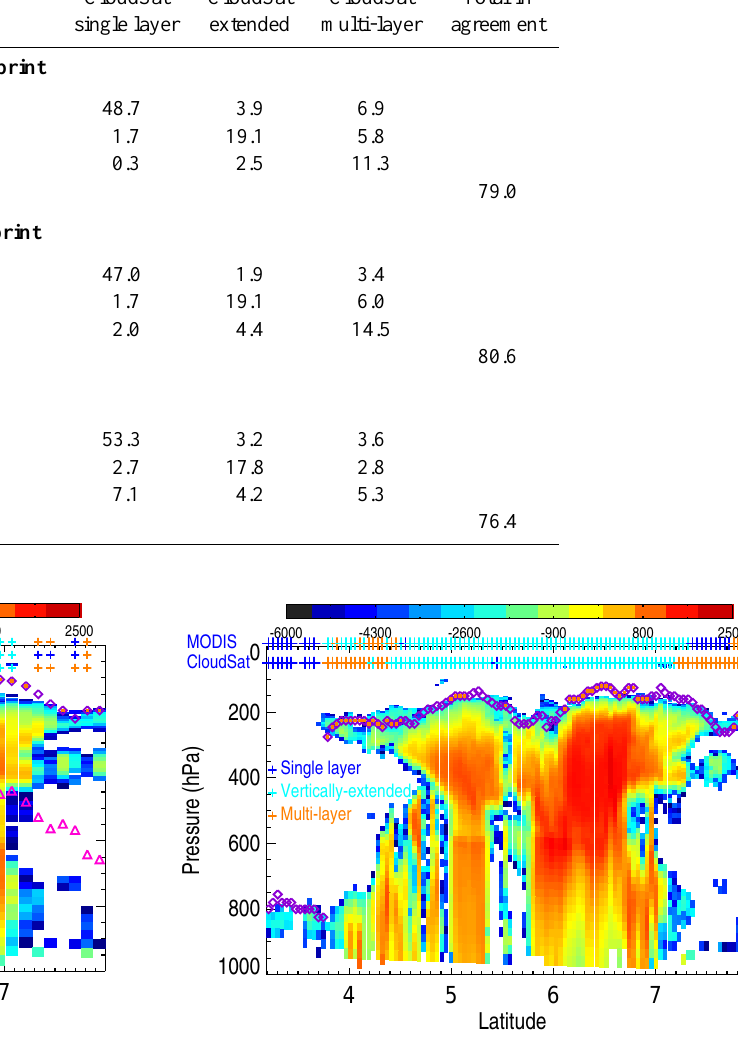
Fig. 7. CloudSat radar reflectivities (arbitrary units) along OMI or- bit 12402 (western track in tropical Pacific highlighted in Fig. 6); Averaged along-track over OMI pixel ( ∼ 13km); Pink triangles: OMI optical centroid cloud pressure; Purple diamonds: MODIS minimum cloud-top pressure within closest passive sensor footprint, orange-filled where MODIS maximum multi-layer flag > 2. Col- ored ’+’ symbols at the top are the results of the cloud classification algorithms described in Figs. 3–5. Results are shown only for pixels passing the filtering scheme described in the Appendix.